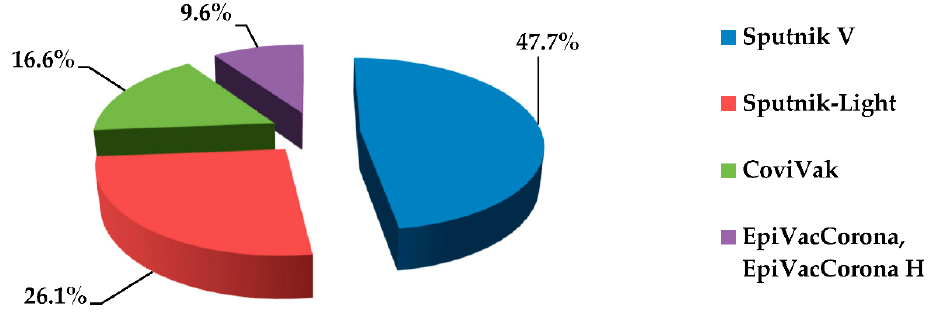
Figure 10. COVID-19 vaccines selected by medical